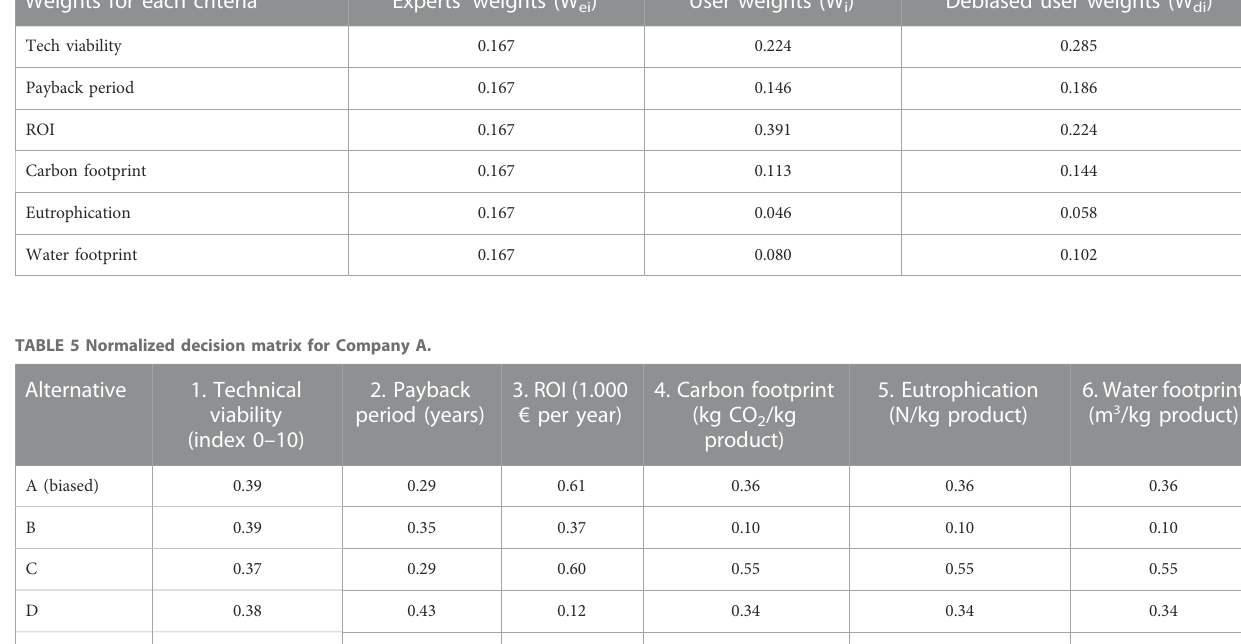
TABLE 4 Criteria weights set by experts, the user, and the debiased user weight following a loss aversion debiasing. Weights for each criteria